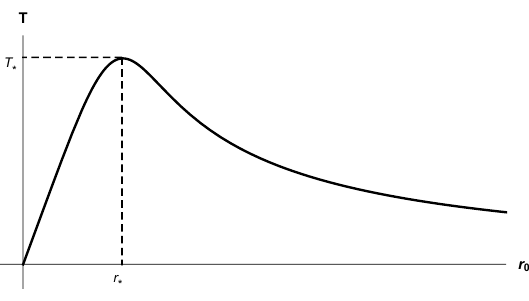
Figure 1 . The Hawking temperature T of a black hole as a function of its size r 0